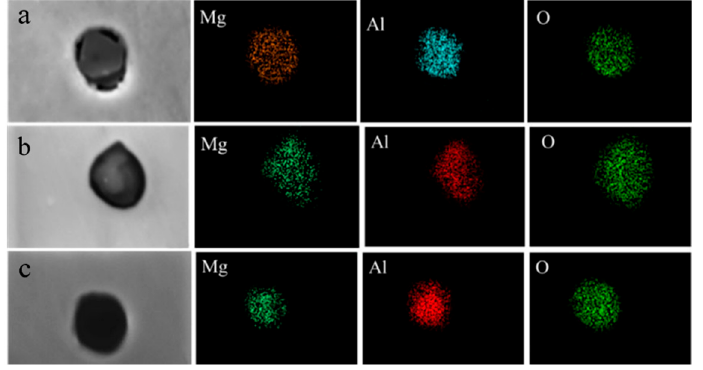
Figure 4. Morphology of typical inclusions in sample M2 (( a ): 60 s; ( b ): 300 s; ( c ): 600 s).